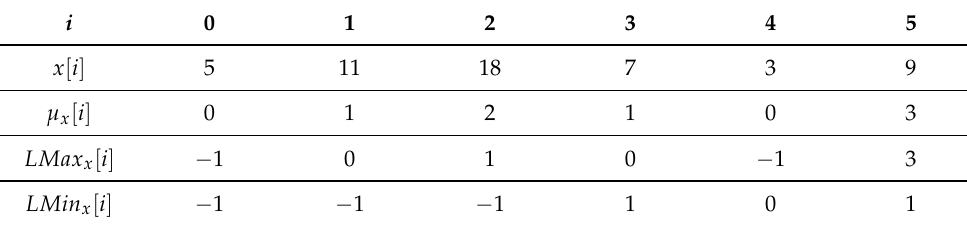
Table 1. Prefix table µ x and location tables LMax x and LMin x for x = ( 5,11,18,7,3,9 )